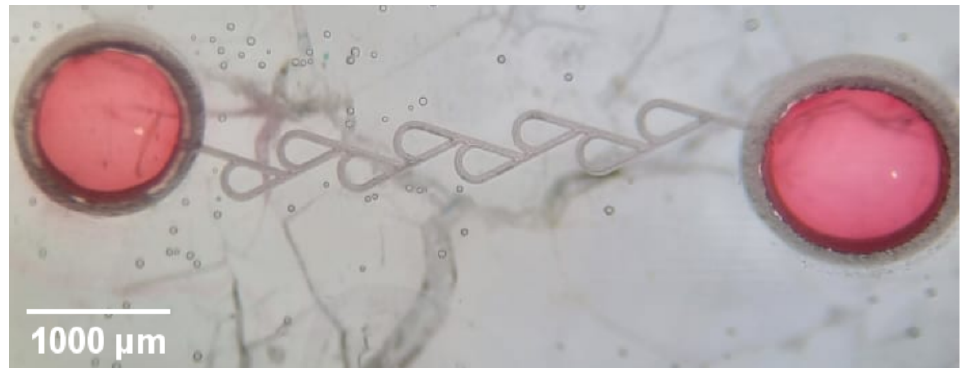
Figure 8. Optical microscope image of Tesla valve testing for any leaks by injecting red-colored water. No leaks or blockages can be detected, showing superb sealing through the whole cm-sized